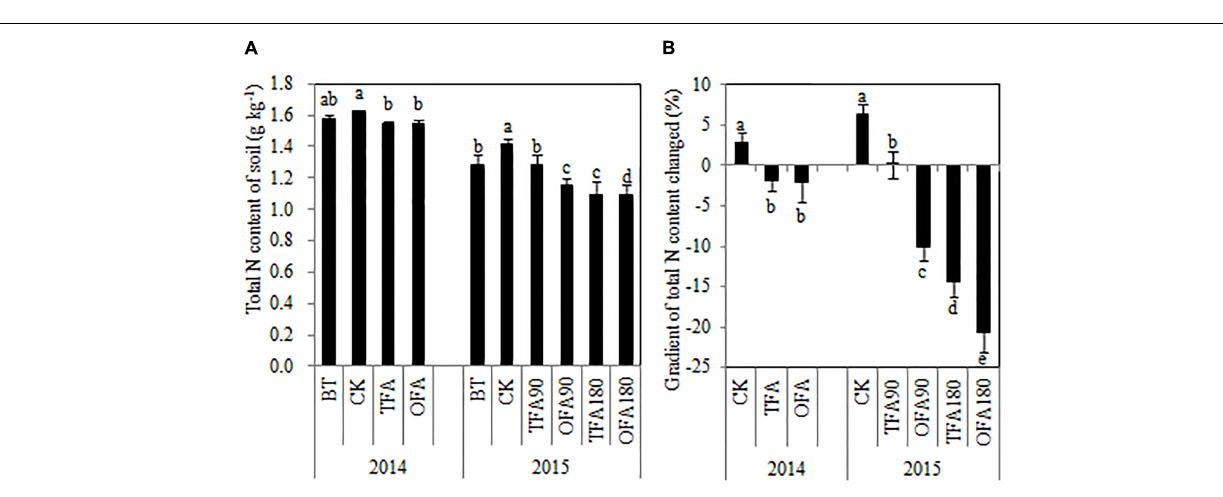
FIGURE 6 | Changes in paddy soil nitrogen after application of different nitrogen sources. (A) Total nitrogen content of soil; (B) gradient of total soil nitrogen content changed. BT: before transplanting, CK: no nitrogen applied, TFA: traditional nitrogen fertilizer application, OFA: optimized nitrogen fertilizer application, 90: